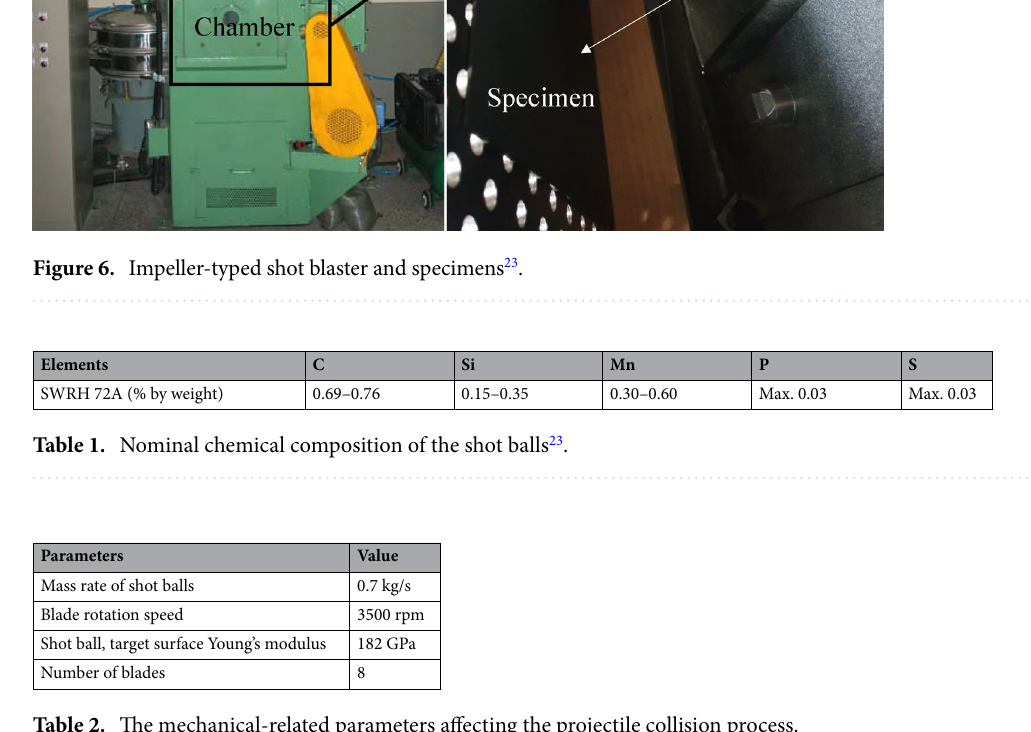
Table 2. The mechanical-related parameters affecting the projectile collision